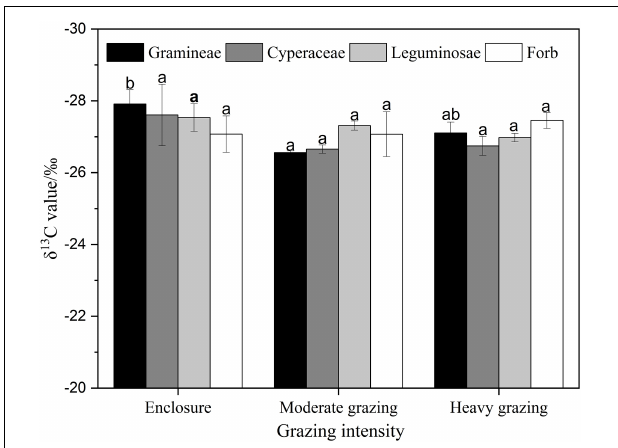
FIGURE 3 | δ 13 C values of functional group species under different grazing intensities. Different letters of the bar graph of the same color indicate a significant difference between the two, and the same letter indicates that the difference is not significant.